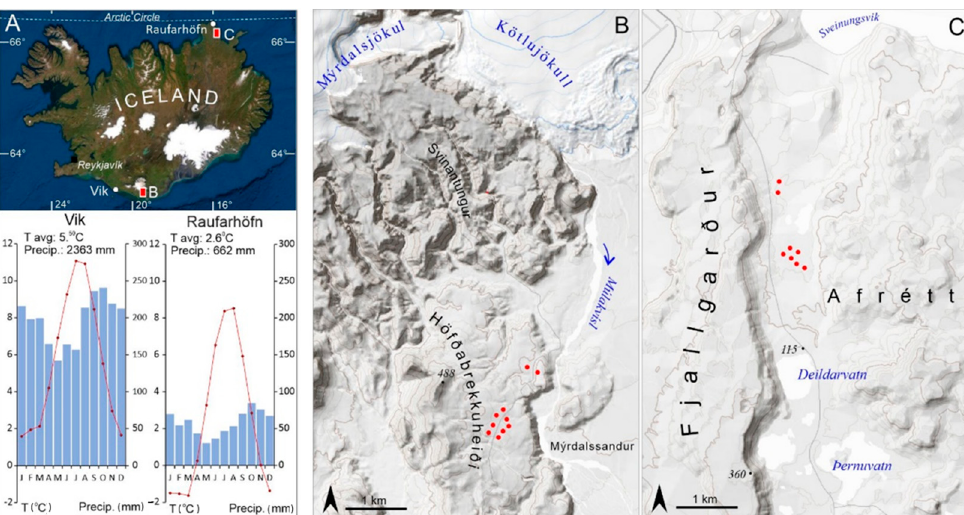
Figure 1. ( A ) Location of the study areas and meteorological stations with climatographs from Southern (Vik) and Northeastern (Raufarhöfn) Iceland; detailed locations (red points) of sampling sites at ( B ) the Mýrdal site and ( C ) the Afrétt site (source of background maps: National Land Survey of Iceland, https://www.lmi.is/, accessed on 15 November 2021).